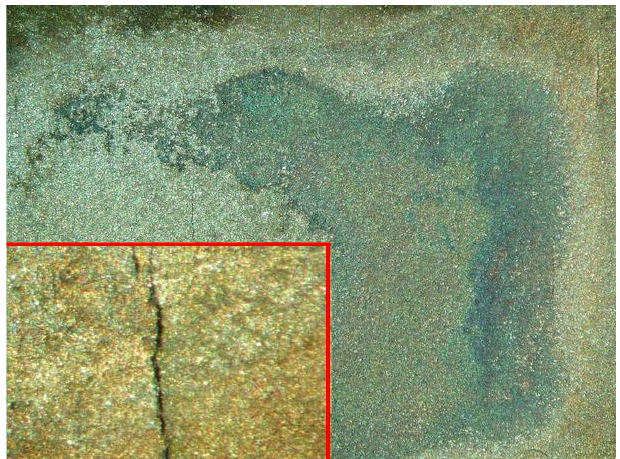
FIG. 5. (Color) Downstream surface of the target dosed with the KEKB390 mode (target 1). The horizontal size of this picture corresponds to 10 mm. As can be clearly seen, the surface color on the left-lower corner is an expanded image, where a crack is observed. The horizontal size corresponds to 1 mm.